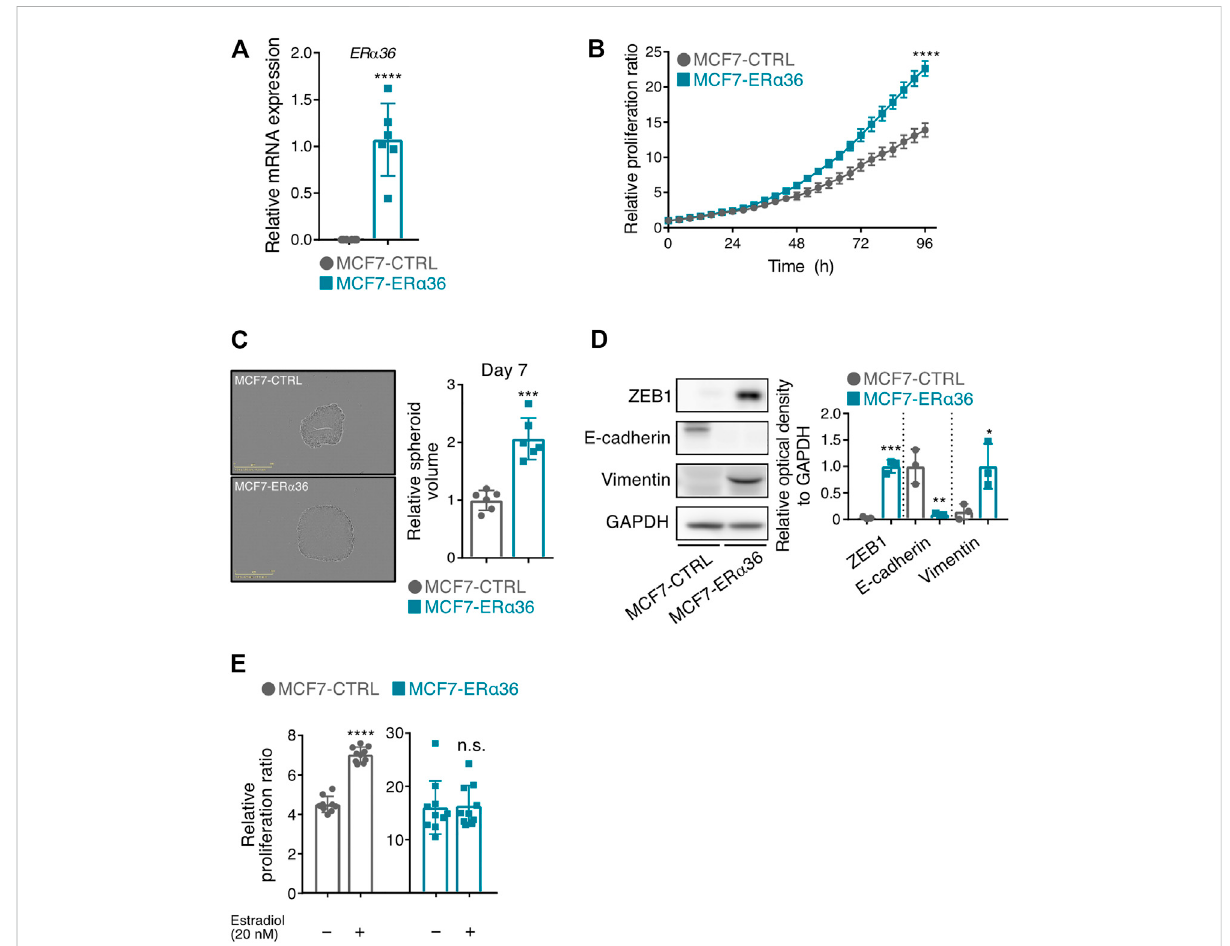
FIGURE 1 OverexpressionofER α 36inMCF-7cellspromotescellproliferation,3DspheroidformationandEMT-phenotypicchange. (A) ThemRNAlevelof ER α 36wasveri fi edbyRT-qPCRinMCF-7-CTRLandMCF-7-ER α 36cell. (B) Proliferationoftheindicatedcellswasmonitoredbyusingareal-timecell imaging system, and therelativeratio was calculated by setting the phase con fl uence at 0 hto 1 (n = 6). (C) Estimation of 3D-spheroid formations by using a real-time cell imaging system. (D) The expression levels of EMT-related proteins were determined in MCF-7-CTRL and MCF-7- ER α 36 cells (left). The relative optical density of those proteins was indicated (right). (E) Proliferation of the indicated cells was determined in the presenceorabsenceof17-beta-estradiol(20 nM)under10%charcoal-strippedFBScondition.Eachphasecon fl uenceat72 hwasnormalizedtothat at 0 h. All statistical signi fi cance of the differences was determined by unpaired two-tailed Student t test. n. s., not signi fi cant; *, p < 0.05; **, p < 0.01; ***, p < 0.005; ****, p < 0.001 signi fi cant as compared with MCF7-CTRL cells (A – D) or vehicle-treated cells (E) . An abbreviation is as follows: CTRL, control